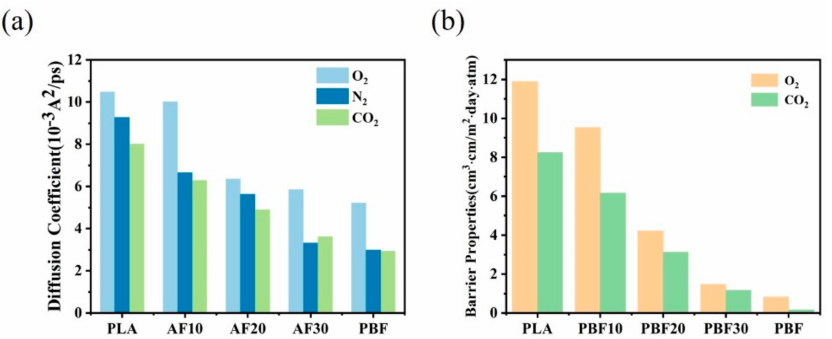
Figure 11. ( a ) Diffusion coefficients of O 2 , N 2, and CO 2 in pure PLA, pure PBF, and blends. ( b ) Barrier properties of O 2 and CO 2 in pure PLA, pure PBF, and blends